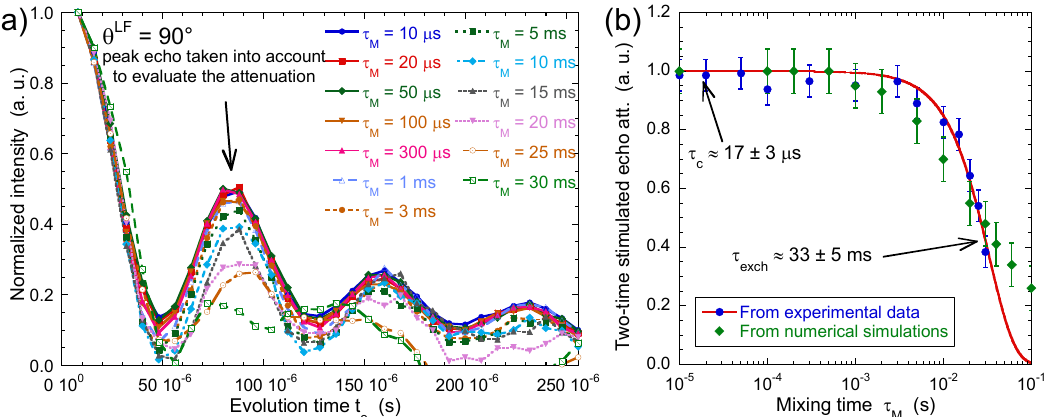
Figure 12. ( a ) Variation of the two-time stimulated echo attenuation I ( t e , τ M ) as a function of mixing time τ M ( 2 H NMR). The data are normalised to take into account the relaxation of the T 20 coherence during the mixing time τ M (see Equation (4)); ( b ) Two-time correlation function extracted from the normalised stimulated echo attenuation as a function of the mixing time τ M . The red line corresponds to the best fit of a stretched exponential function, f ( t ) = A exp ( − t / τ exch ) α , to determine the exchange time τ exch ( τ exch = 33 ± 5 ms with an exponent α set equal to 1.5). The green line dots are obtained by numerical modelling (see text). Reprinted with permission from [23]. Copyright (2014)